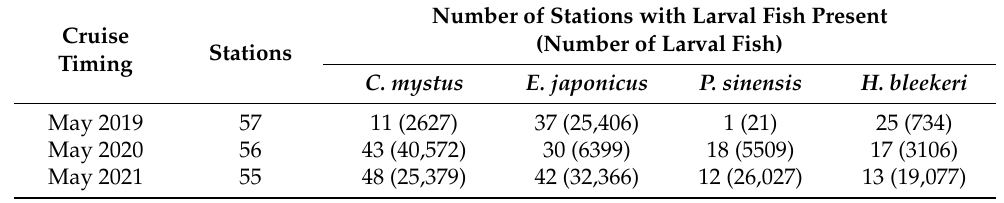
Table 1. Details of larval fish surveys and larval fish collection in the Yangtze